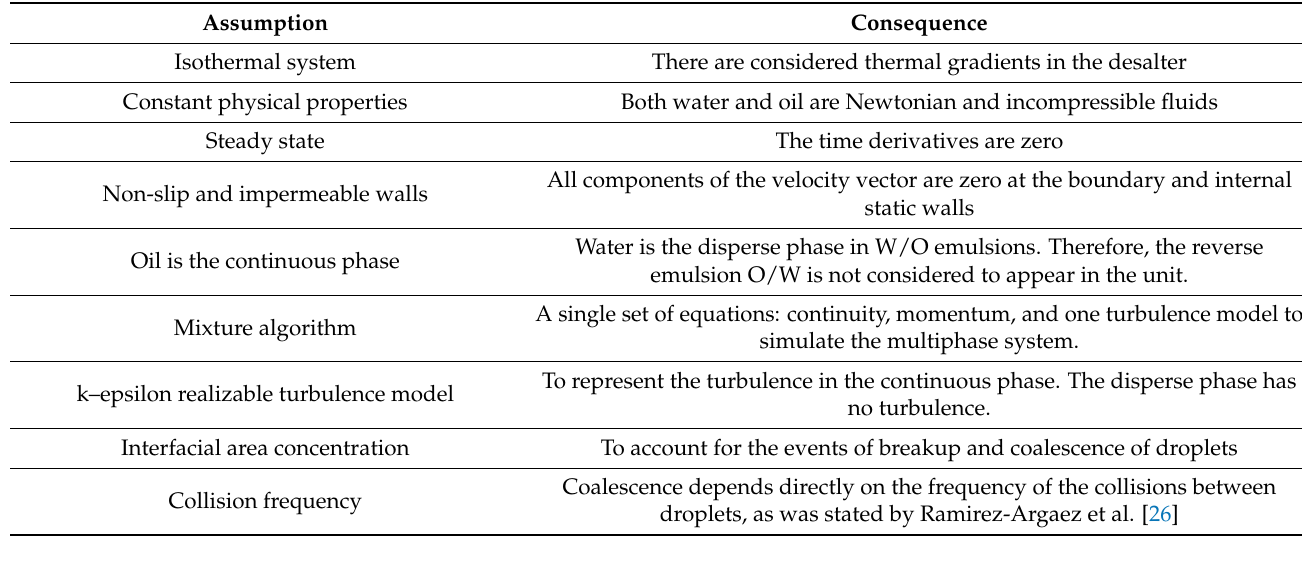
Table 2. List of simplifying assumptions used in the development of the mathematical model.